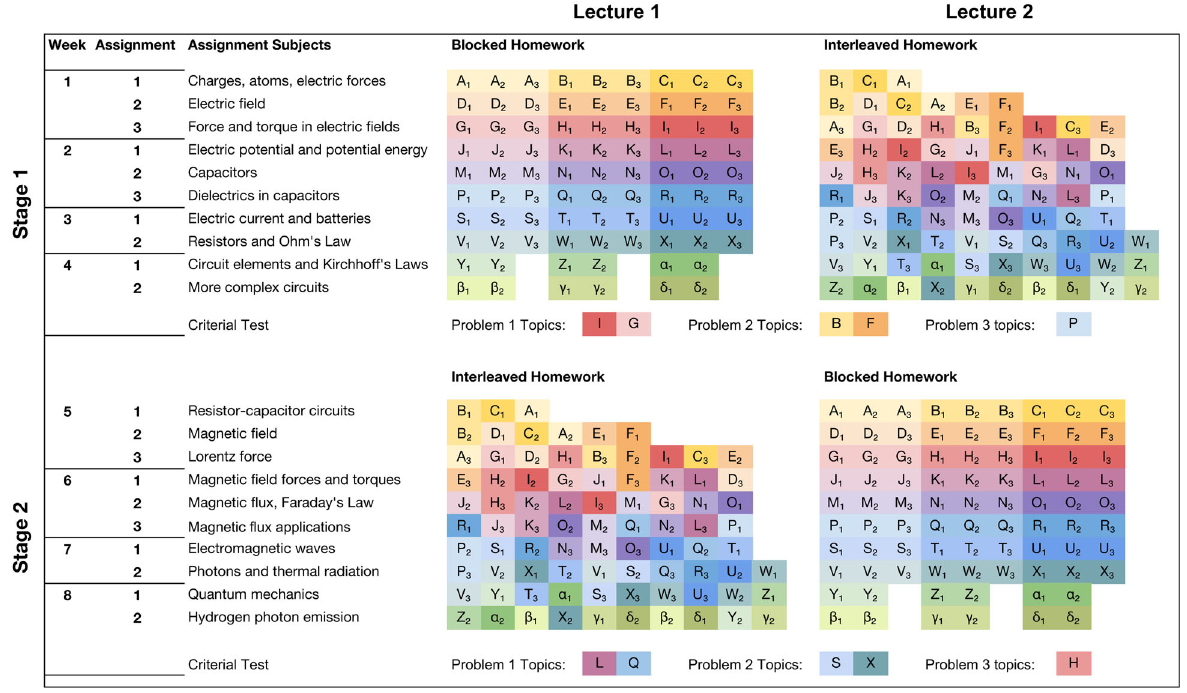
Fig. 1 Interleaved versus blocked practice schedules. In each of the two stages of the course, students completed 84 practice problems across 10 homework assignments. Blocked assignments typically featured three successive problems for each of three topics, whereas interleaved assignments typically featured only one problem per topic. In the fi gure, letters represent topics and subscripts represent the problem number for a given topic (1, 2, or 3). Different topics are also assigned different colors so that it is easier to visually tell them apart. Re fl ecting the relative simplicity of practicing one topic at a time, topics in each row of the blocked condition correspond perfectly to the assignment subject labeling that row, but this is not the case for the interleaved condition. Topics addressed on the criterial tests are also listed. Due to course time constraints, the last two blocked assignments of each stage include only two problems per topic instead of three. Topics from these assignments were not included in criterial